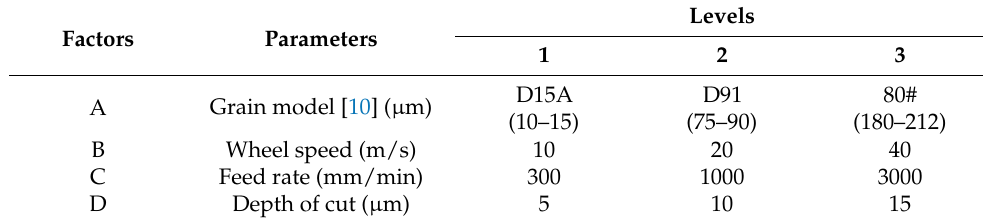
Table 2. The experiment parameters and results (A, B represent the specimen along the <100> and <110> directions grinding).